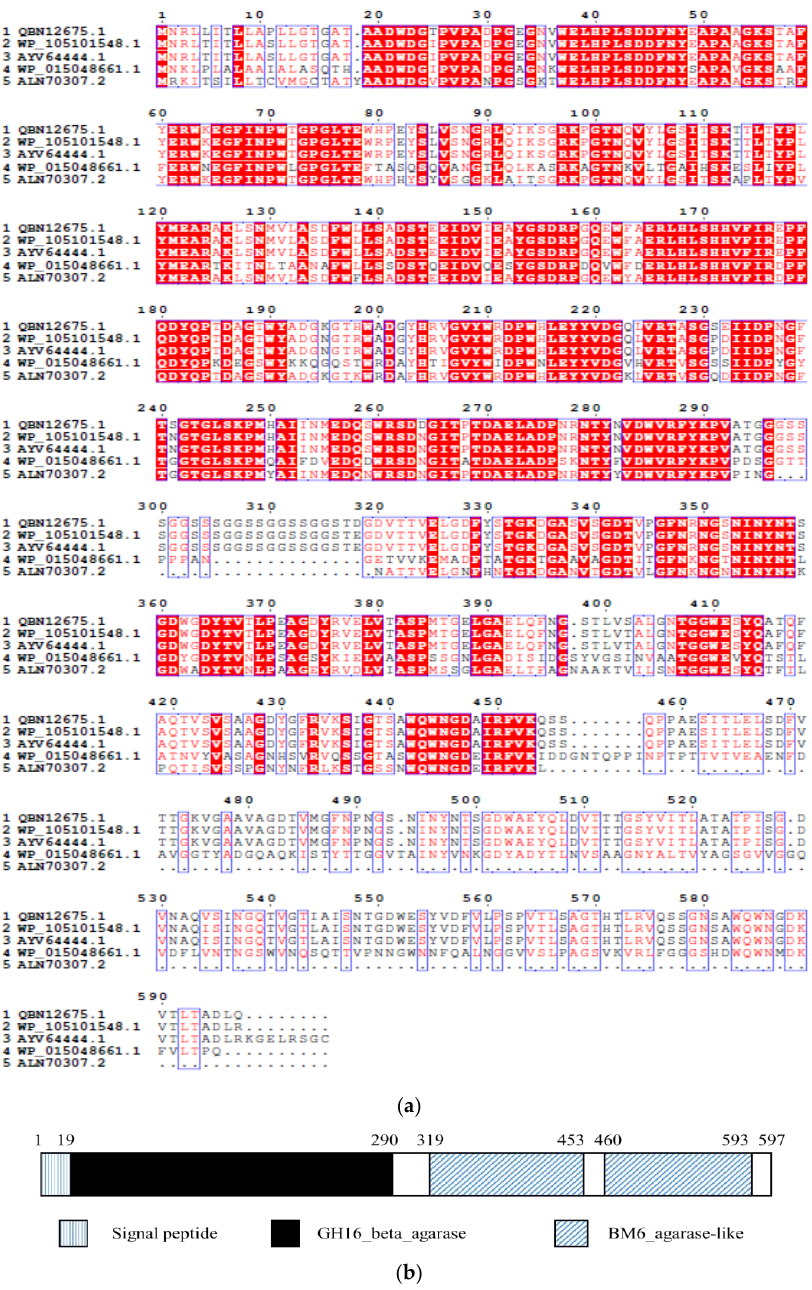
Figure 1. ( a ) Alignment of sequences of β-agarase from Microbulbifer sp. BN3 with agarases from Microbulbifer pacificus (WP_105101548.1, AYV64444.1) (97% similarity), Microbulbifer sp. AG1 (ALN70307.2) (56% similarity) and Simiduia agarivorans (WP_015048661.1) (53% similarity); catalytic site residues are highlighted in the rectangular frame; the catalytic domain and the carbohydrate binding module (CBM) domains are indicated by double arrows. ( b ) Conserved domain analysis of the agarase (Aga-ms-R) by NCBI and signal peptide prediction by SignalP